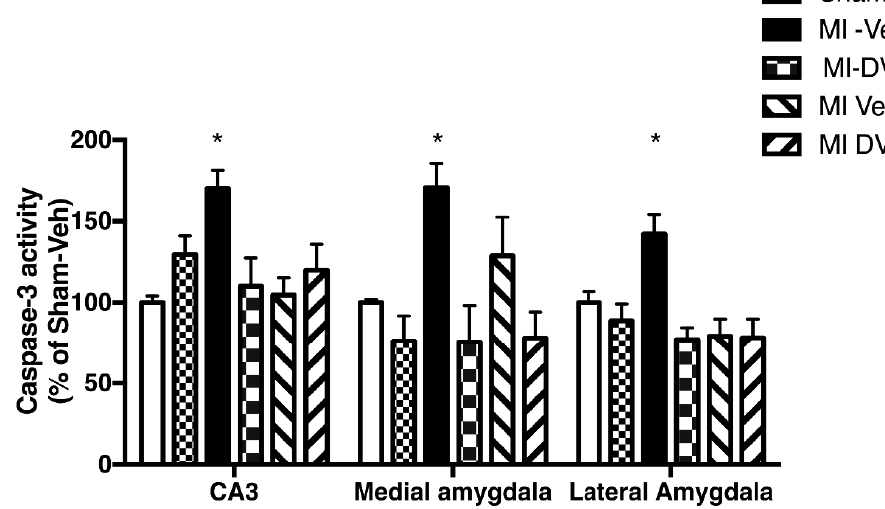
Figure 5. Caspase-3 activity. Casapse-3 activity in the CA3 region of the hippocampus, the medial